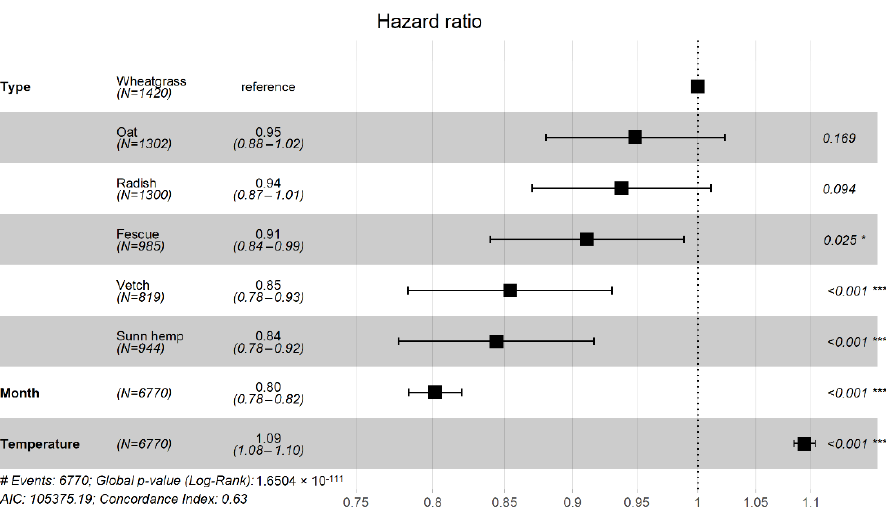
Figure 4. Hazard ratio test demonstrating differences in preferences between seed types. Reference is wheatgrass. Means and standard errors on the right side of the chart indicate a larger number of seeds that were removed during the trial compared to wheatgrass (control), June (month), and 28 ◦ C (temperature). Differences in month n (observed seed number) were due to differences in numbers of trials per month and temperatures at the time of seed count as well as censorship due to external events. Expanded hazard ratios for month and temperature can be seen in the Supplemental Materials (Figure S2). Asterisks indicate the relative p -values indicating statistical significance where * indicates p <0.05 and *** indicates p <0.001. Table 2. Summary of the fitted Cox proportional hazards model for cover crop seed preferences. Coef indicates variable coefficients, SE indicates the standard error, Z is the test statistic used, and P indicates the significant values. Model output for month and temperature can be found in the supplemental material (Table S1).